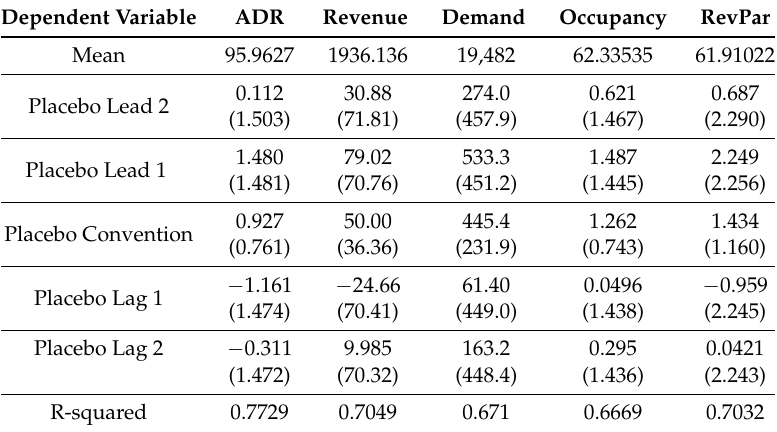
Table 14. Placebo test on convention